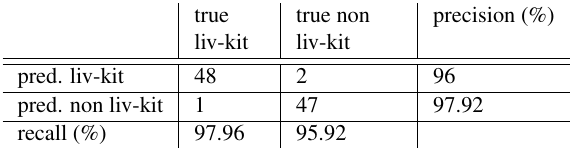
Table 2. Classification results of combined